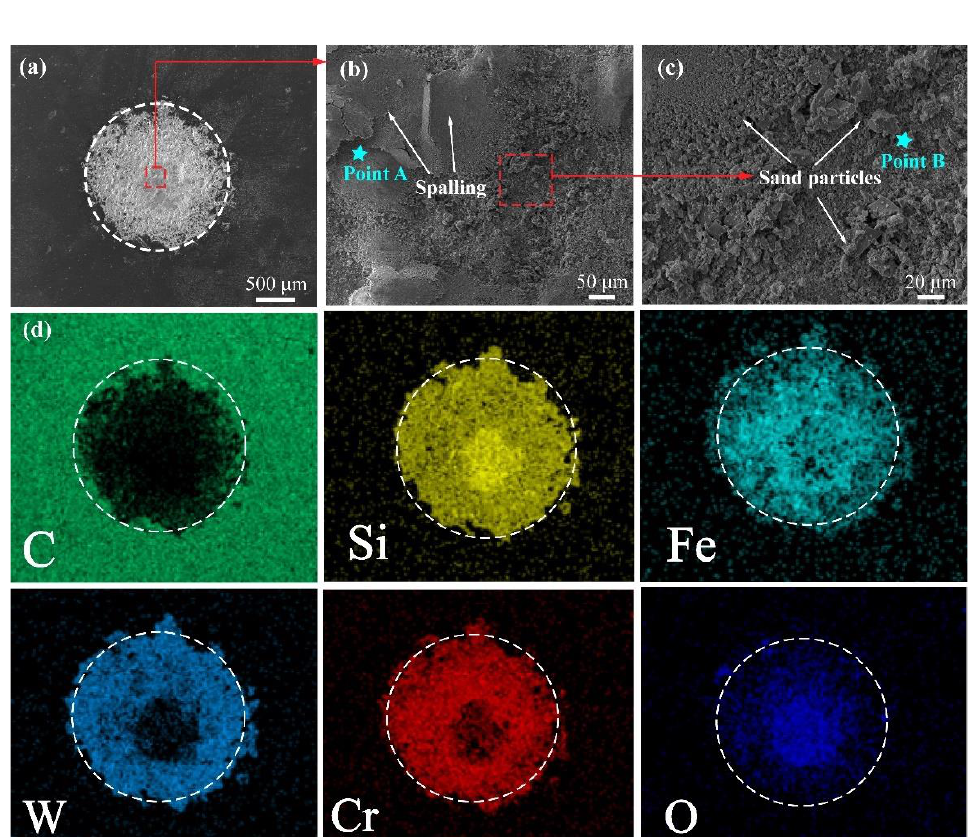
Figure 10. Wear scar topography and elemental distribution of Cr/W-DLC/DLC multilayer films at RT under the sand condition: ( a – c ) wear scar topography; ( d ) elemental distribution.